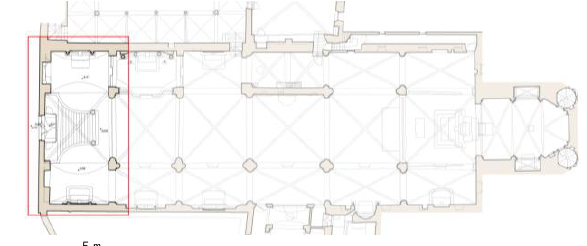
Figure 5. The analysed part of San Giovanni Church (in the red